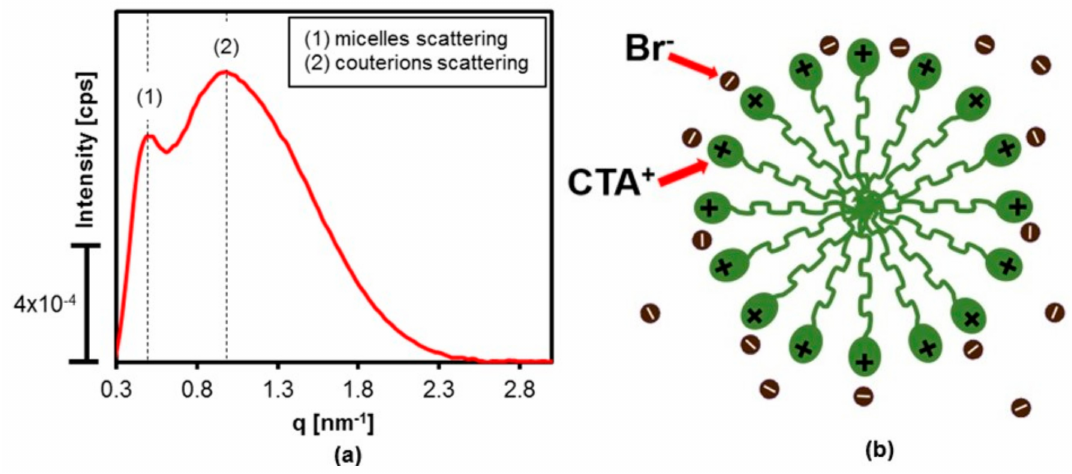
Figure 4. ( a ) SAXS curve of the aqueous 0.064 mol · L − 1 CTABr dispersion used for [CTA]-MCM-41 preparation; ( b ) schematic representation of the CTABr